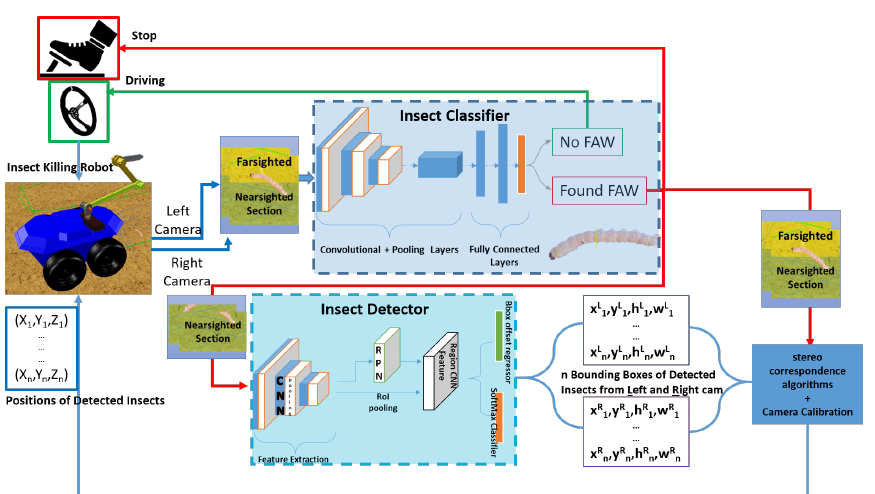
Figure 3. Proposed deep learning-based robot-centered insect pest larvae recognition overview.